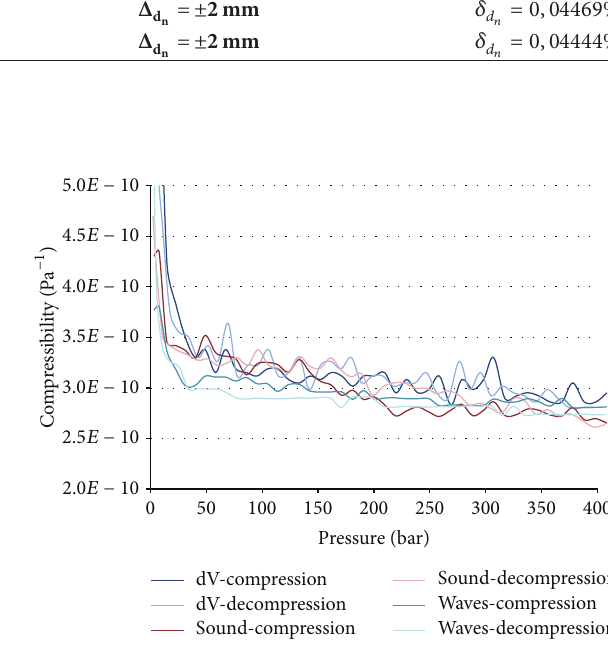
Figure 5: Compressibility of ionic fluid EMIM EtSO 4